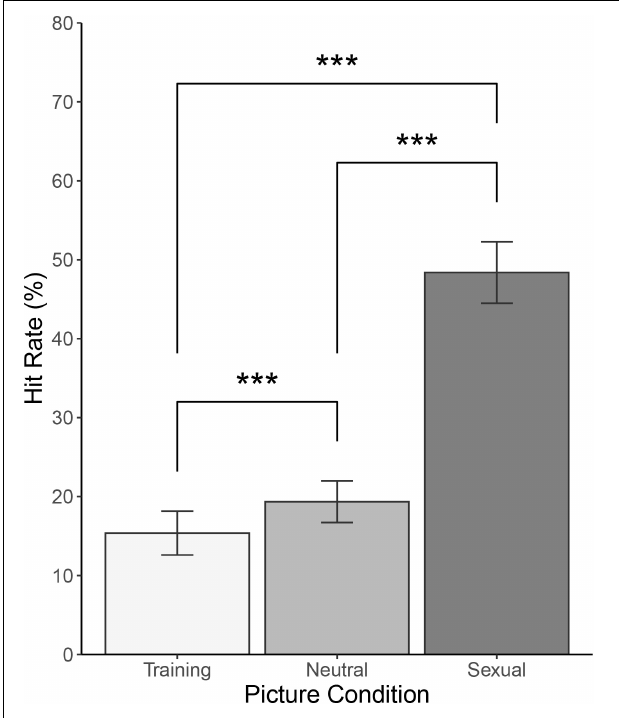
FIGURE 3 | Picture recognition task: Correct recognition (%) for training, neutral, and sexual pictures. *** p <